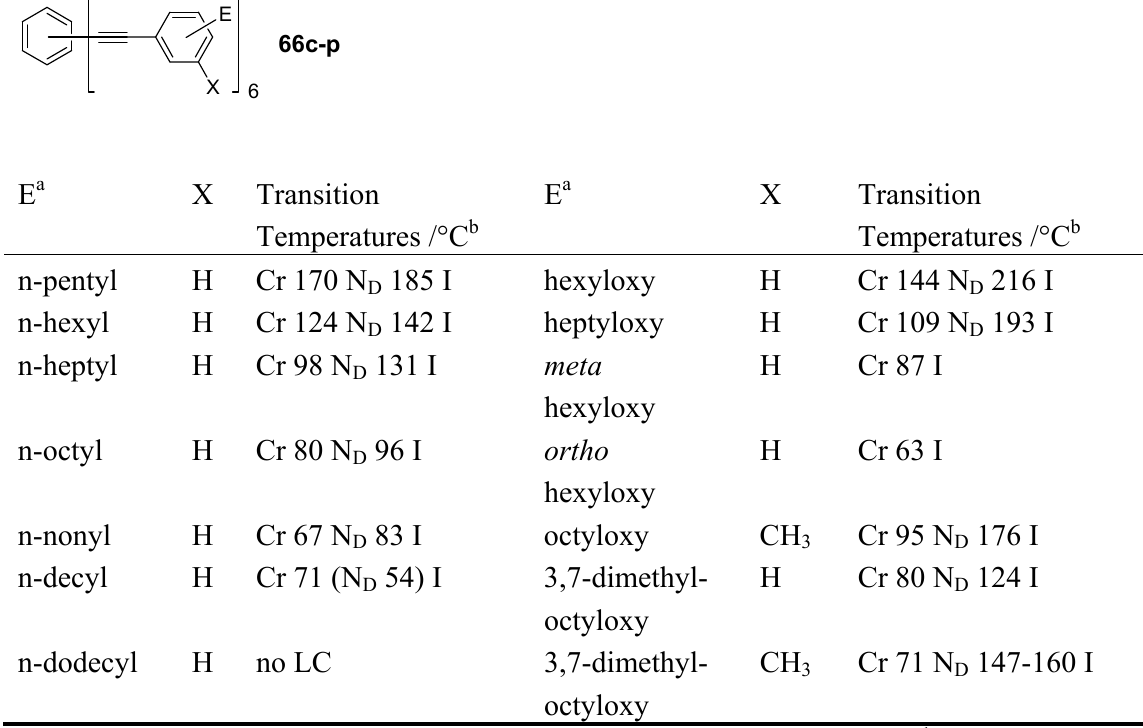
Table 6. Hexaarm systems with a benzene core and phenylethynyl arms.